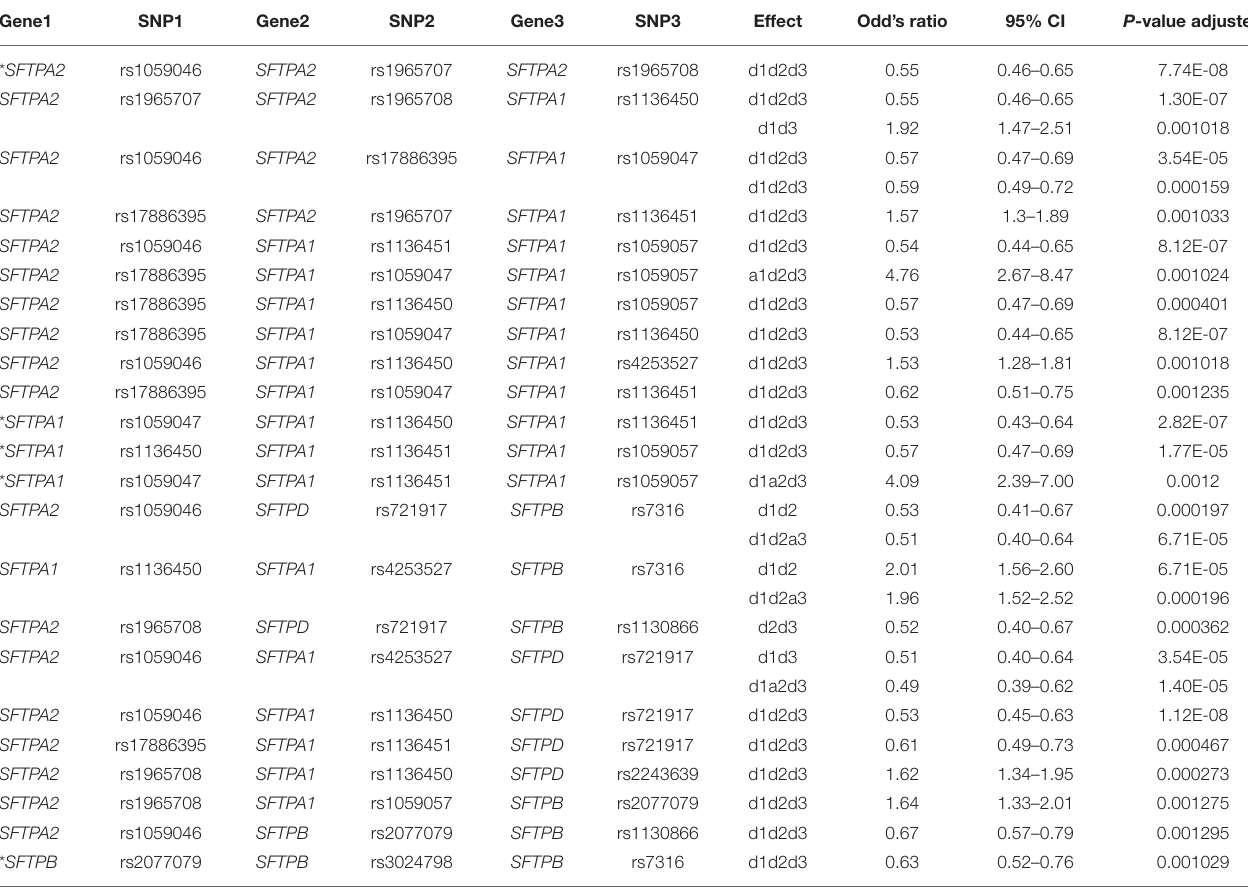
TABLE 4 | Three SNP-SNP-SNP interactions of surfactant protein genes associated with RDS.